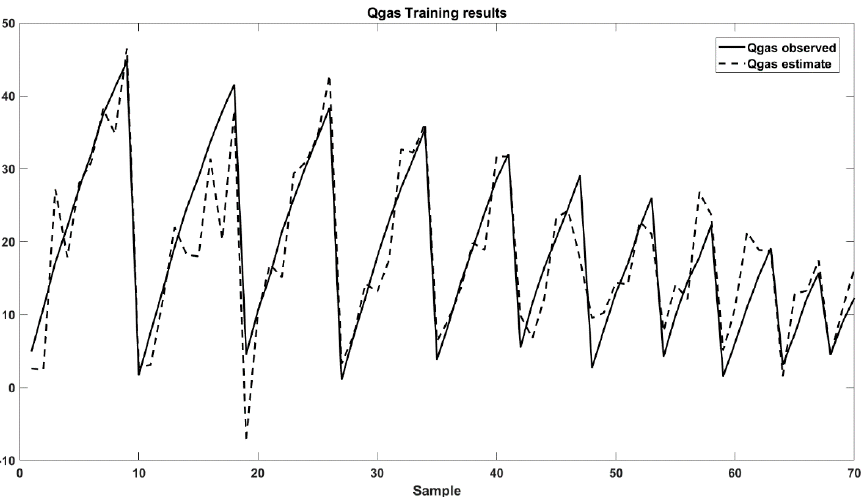
Figure 7. Comparison of observed and estimated intake air flow rate with NN at 2 hidden levels 10 and 10 neurons.